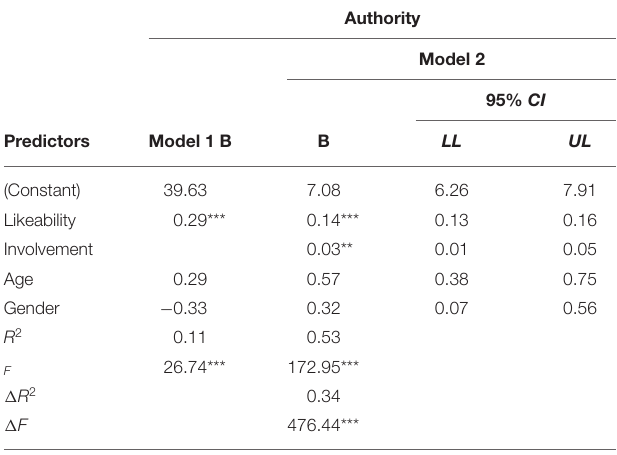
TABLE 8 | Mediating effect of perceived parenting between self-concept and narcissism ( N = 628).